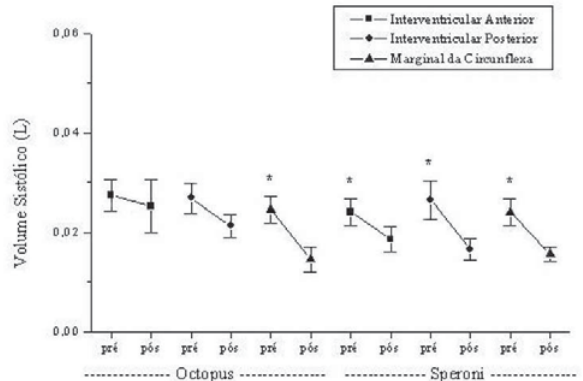
Fig. 3 - Volumes sistólicos pré e pós-estabilização com o Octopus e Speroni. Valores médios com dois erros padrão da média (EPM). (*) diferença com significância estatística (p<0,05)